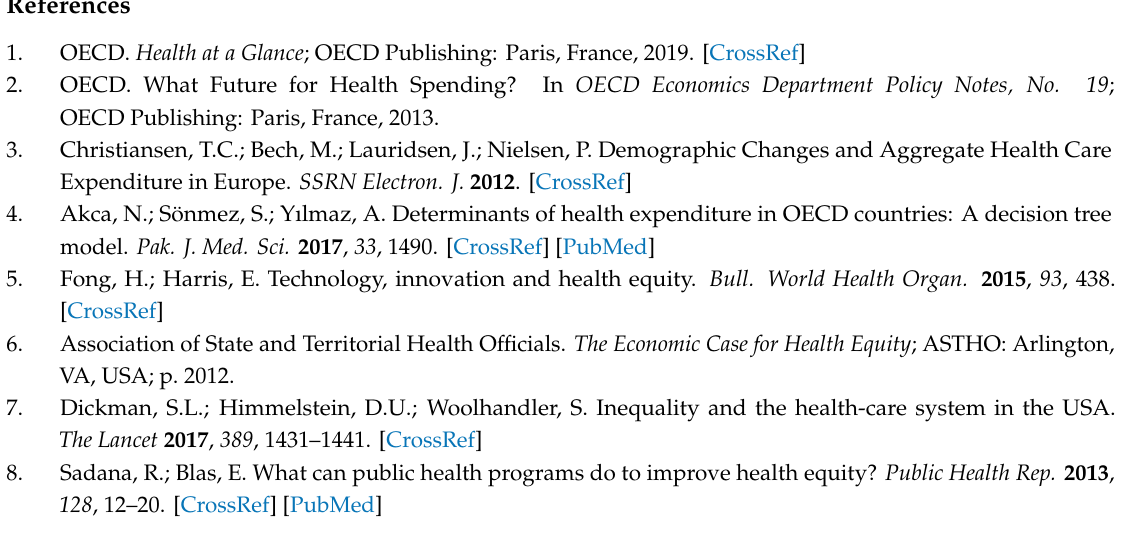
Figure A2. Distribution of the standardized residuals from Model C with the fitted normal distribution curve. (Kolmogorov-Smirnov test: p = 0.017, df: 4814).